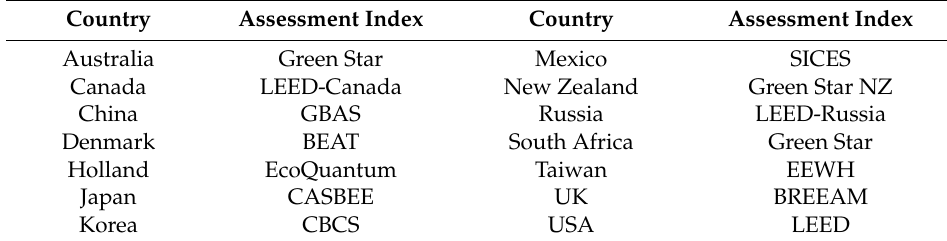
Table 1. Global green building assessment